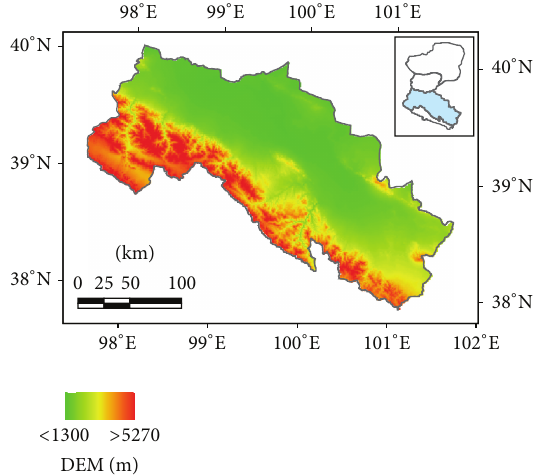
Figure1:Locationandgeographicboundariesofthemiddlereaches of the